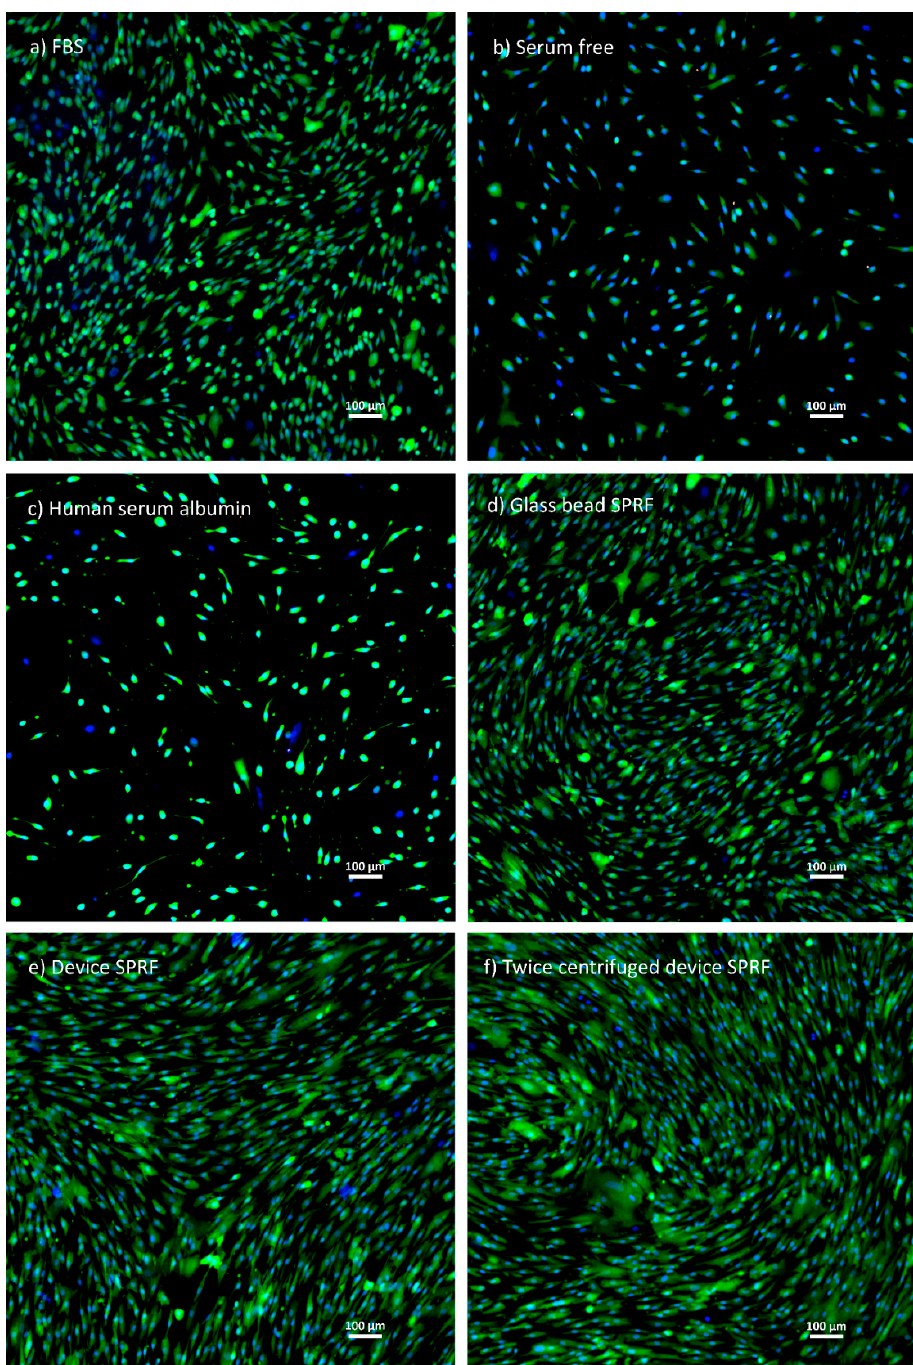
Figure 4. Morphology of MSCs cultured in different serum-containing media. Living cells are green, the nuclei are blue, no dead cells can be seen.